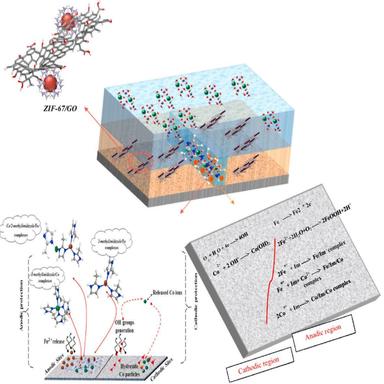
Self-healing schematic illustration of ZIF-67/GO corrosion-mitigative function for the epoxy coating.